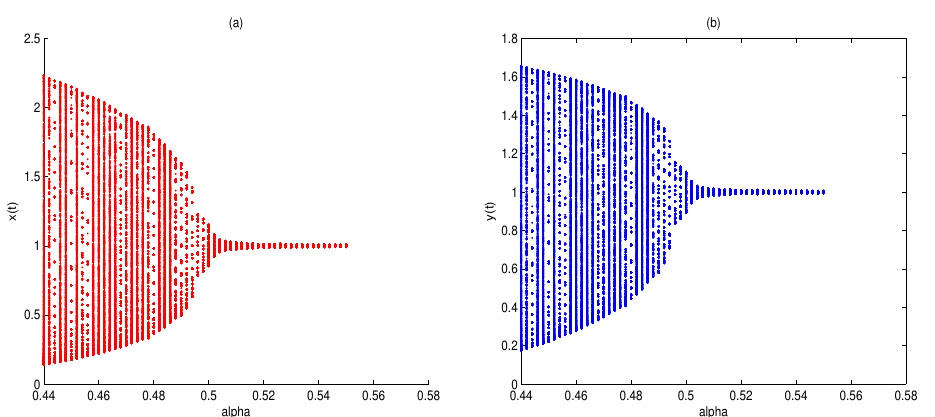
Figure 17. There is a supercritical Hopf bifurcation when ξ passes through 0, i.e., α passes through 0.5. In here r = 2, ω = 1, b = 1, c = 2. ( x ( 0 ) , y ( 0 )) = ( 0.9,0.9 ) . A 5 ( 1,1 ) . Subigure ( a ) is a bifurcation diagram of x ( t ) with respect to α and subfigure ( b ) is a bifurcation diagram of y ( t ) with respect to α .